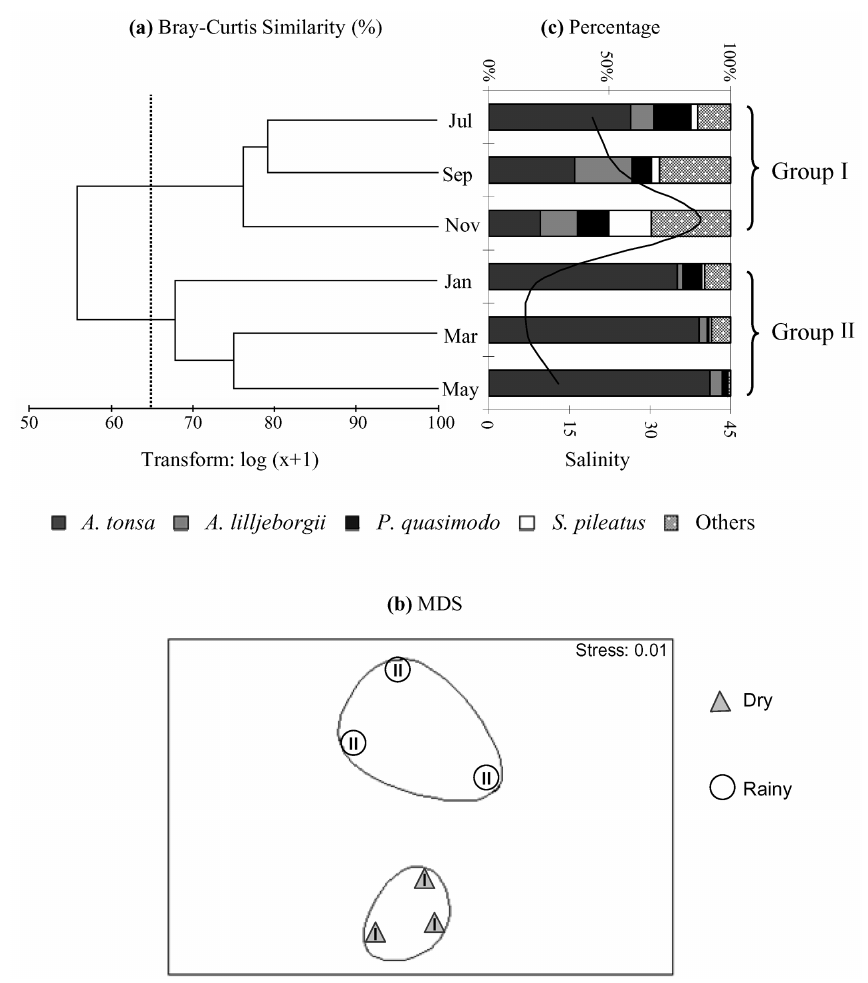
Fig. 5 – Cluster (a) and MDS (b) analyses based on copepod taxa densities during dry (group I) and rainy (group II) sampling months in the Curuçá estuary. Percentage of the main taxa density (c). These data were plotted against salinity